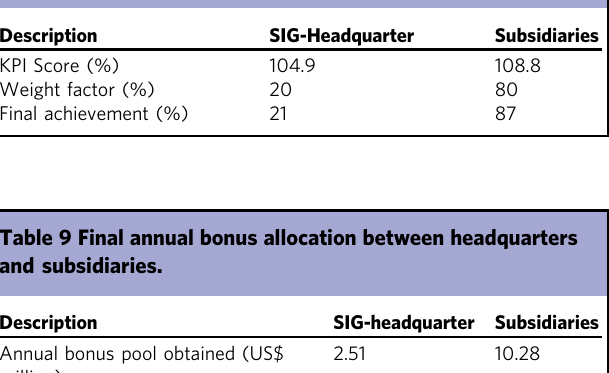
Table 8 Determining the portion between headquarters and subsidiaries.